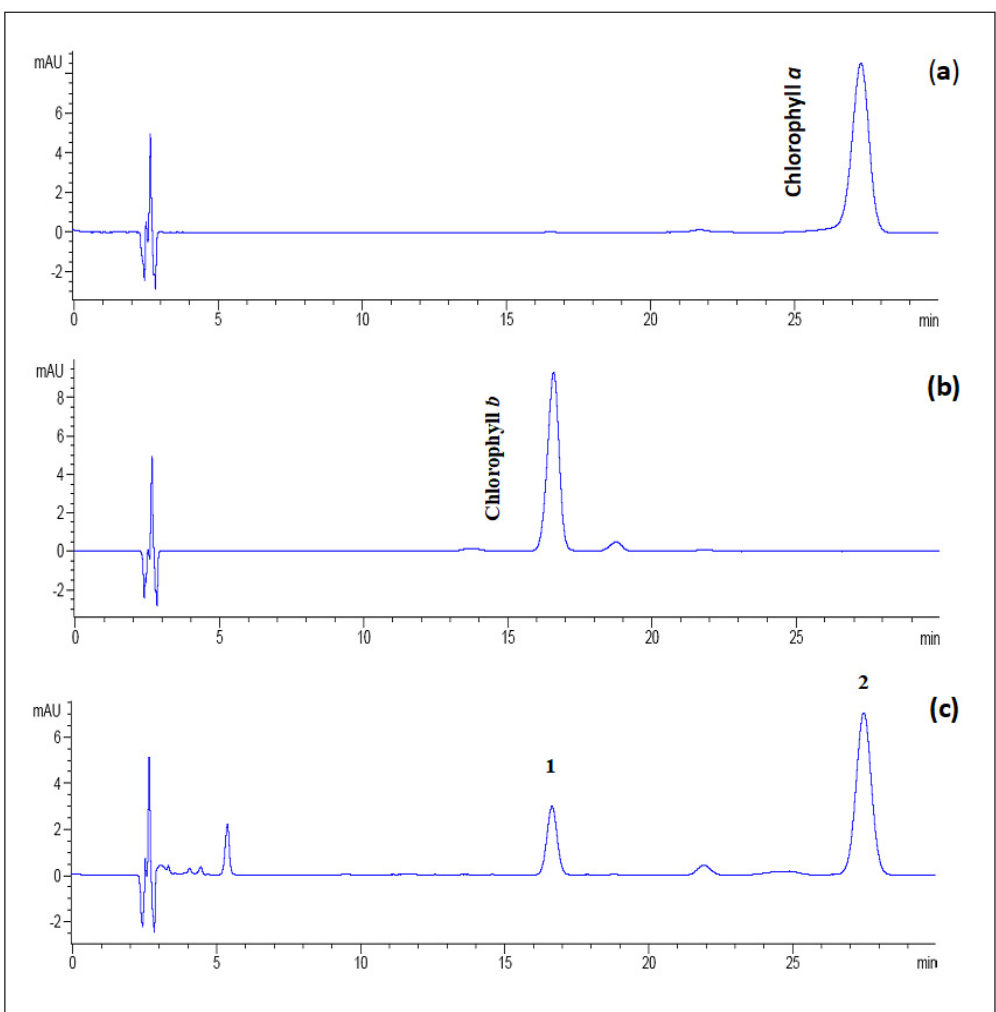
Figure 9. The reversed-phase HPLC chromatograms of ( a ) standard chlorophyll a , ( b ) standard chlorophyll b , and ( c ) fresh amaranth puree extracts (peaks identification: 1 = chlorophyll b and 2 = chlorophyll a ) were detected at a wavelength of 658 nm. The separation process was carried out using a reversed-phase C 18 column with an isocratic mobile phase of ethyl acetate/methanol/water (40:54:10